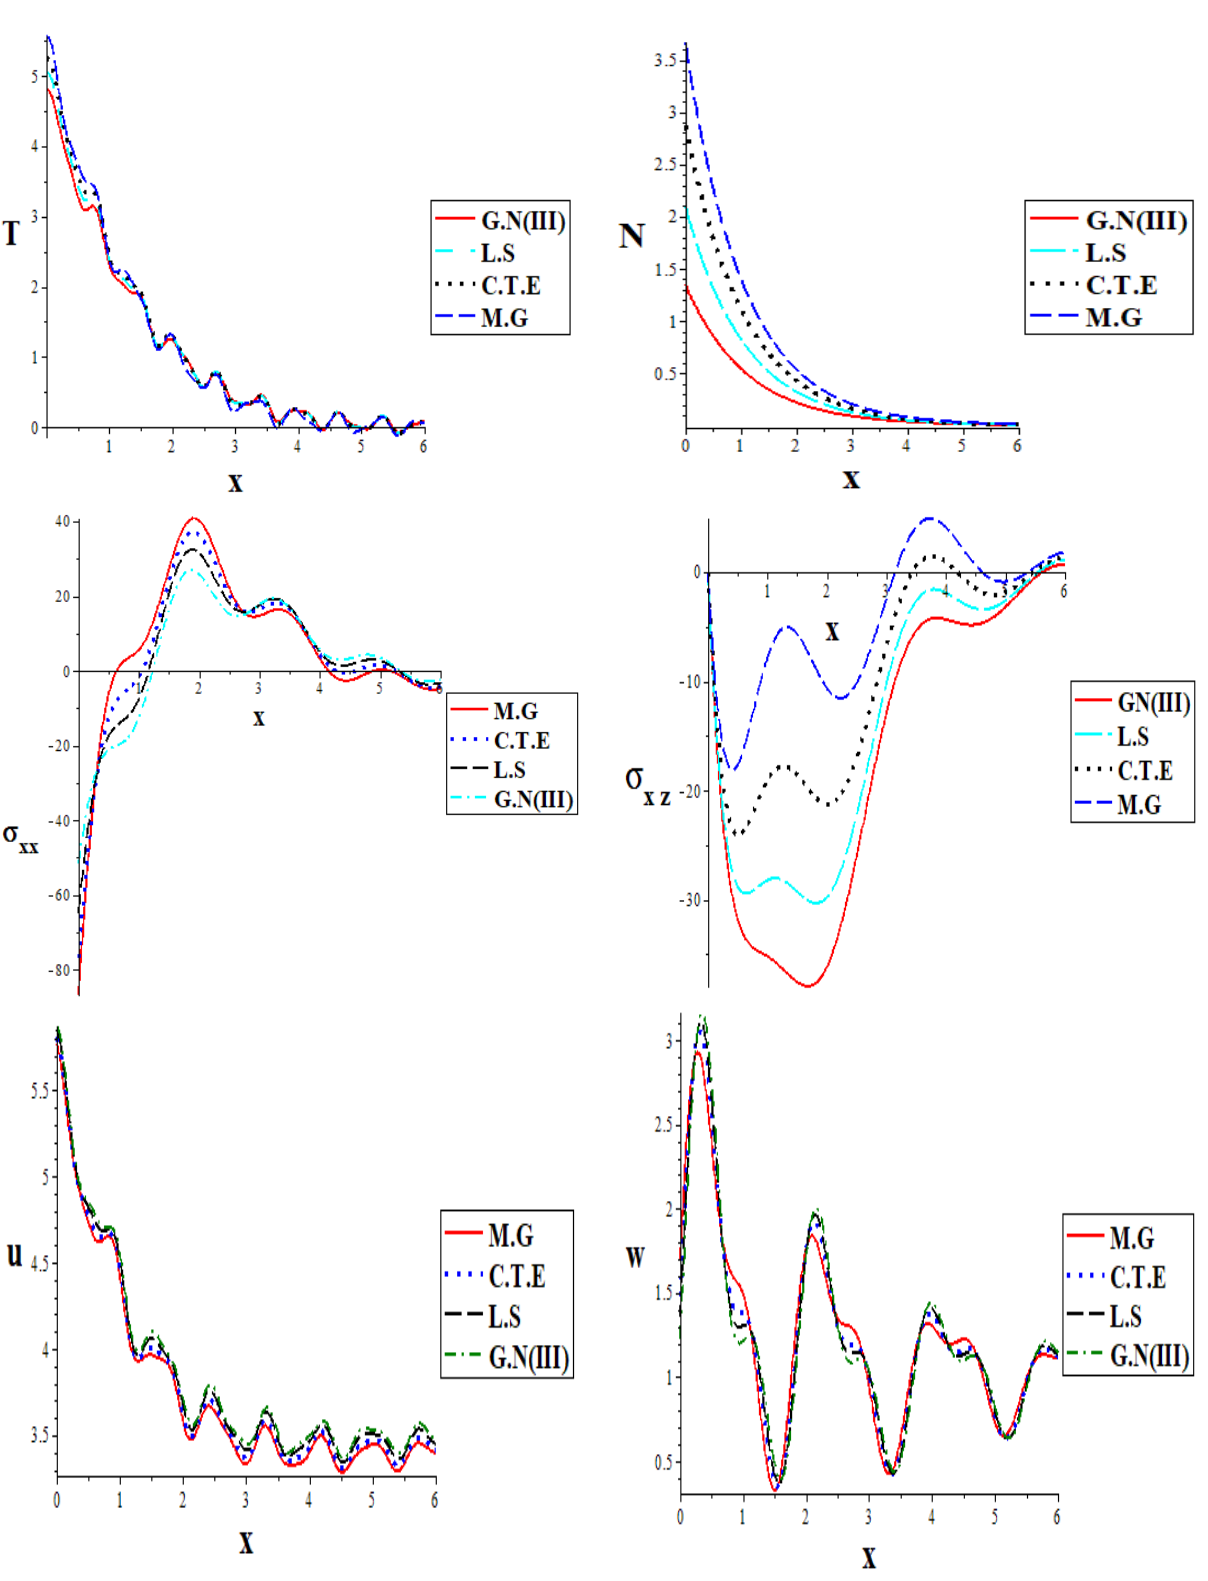
Figure 2. The main changes in the physical fields plotted against the horizontal distance for various photothermoelastic models in a rotational field and under initial hydrostatic stress when t = 0.3